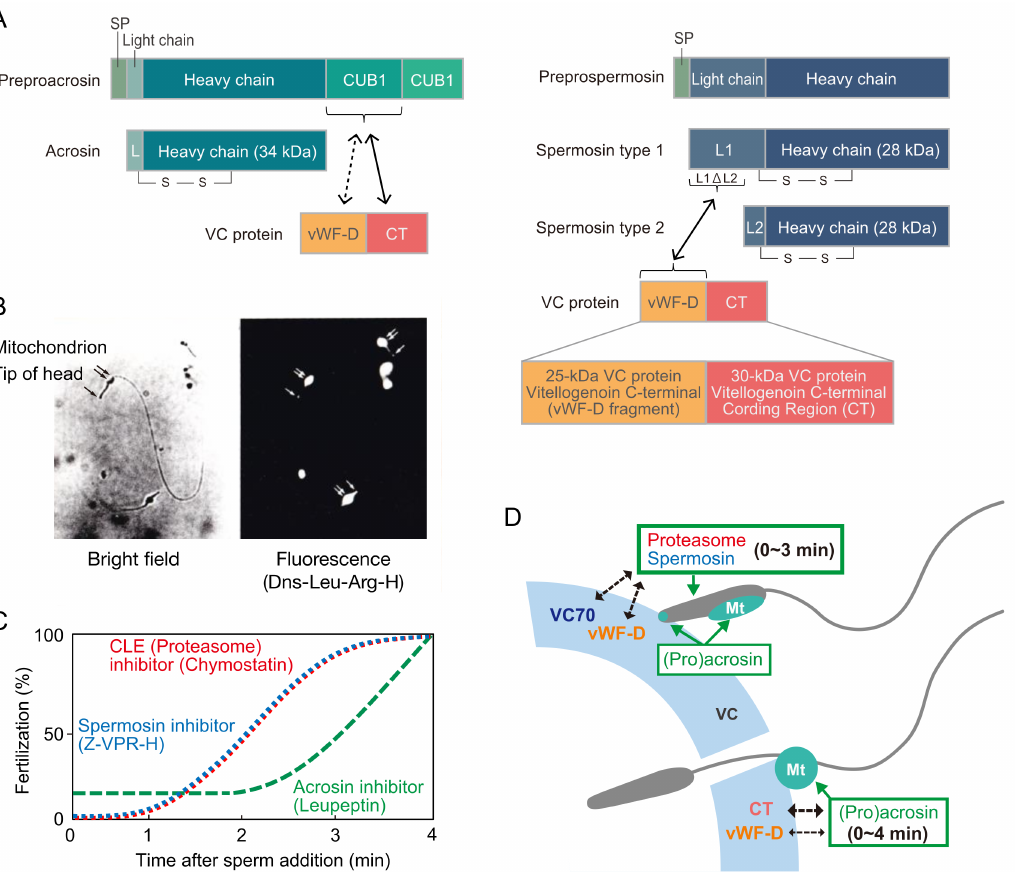
Figure 4. ( A ) Domains of H . roretzi sperm trypsin-like proteases and their binding proteins. ( B ) Localization of Hr acrosin. Acrosin is revealed by the fluorescent-labeled acrosin inhibitor dansyl- leucyl-argininal (Dns-Leu-Arg-H). Strong fluorescence of the dansyl group was observed at the tip of the sperm head (single arrow) and mitochondrial region (double arrows) attached to the side of the sperm head. ( C ) Functioning time of sperm proteases. ( D ) Working hypothesis for the roles and timing of sperm